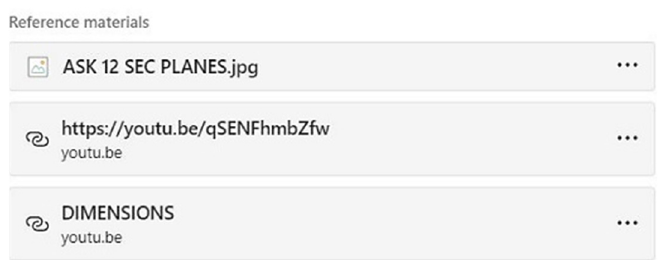
Figure 2. Rotated object.